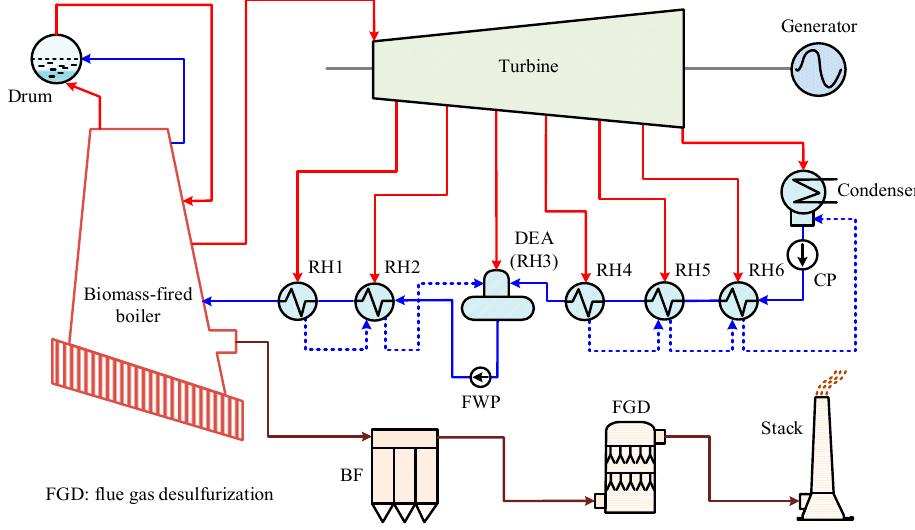
Figure 2. Reference biomass-fired power plant. Table 4. Basic parameters of the reference biomass-fired power plant.